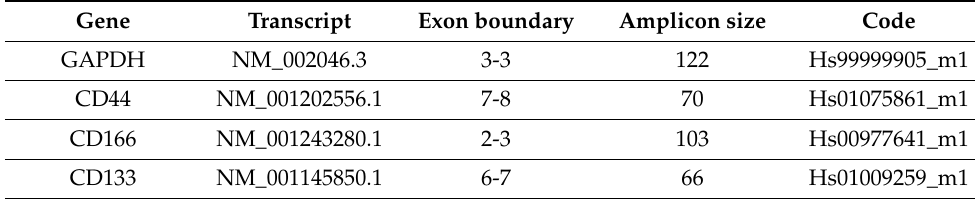
Table 4. TaqMan Gene Expression Assays.